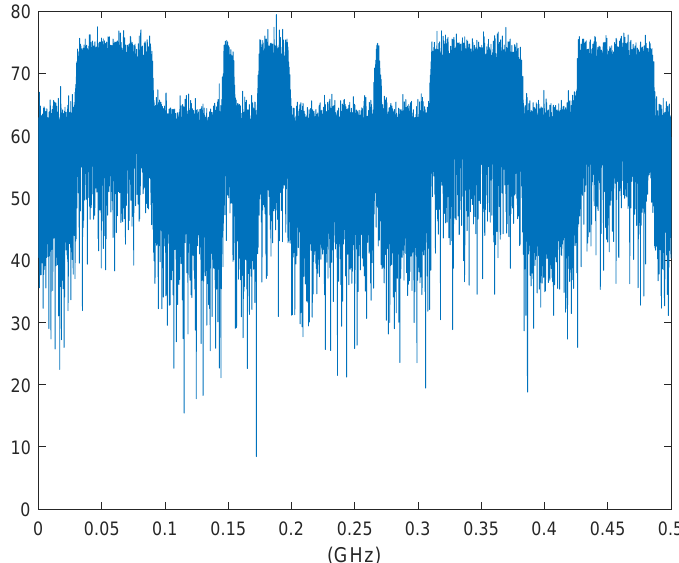
Figure 7. Spectrum of data subcarriers of NC-OFDM.